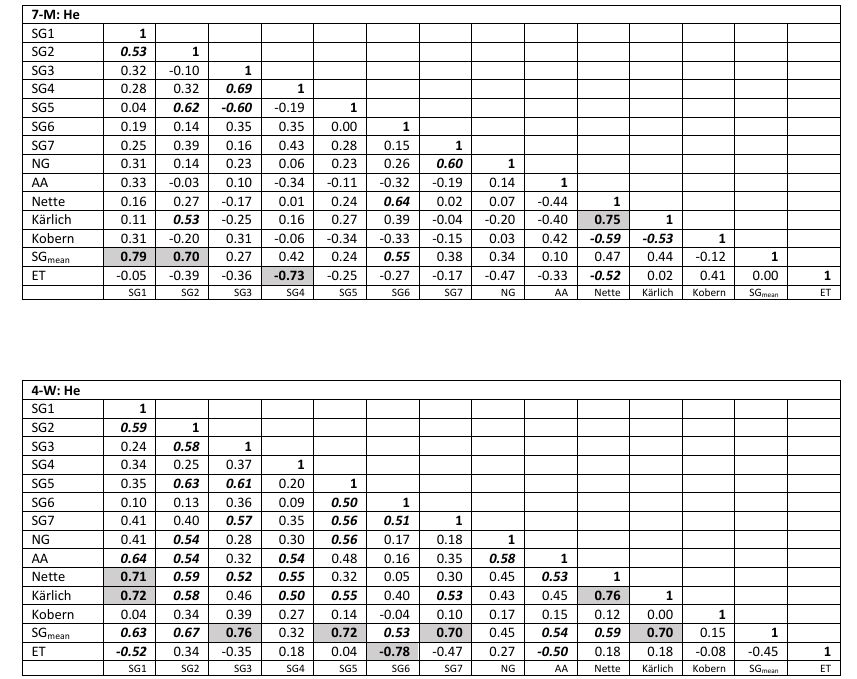
Figure A3. Correlation coefficients between CO 2 fluctuation patterns in NG, SG, SG mean , mineral springs, and Earth tides (ET) for the 7-M and 4-W samples. Correlations >0.70 are shaded. Correlations 0.5–0.7 are marked in bold-italic; n.a.: not available.